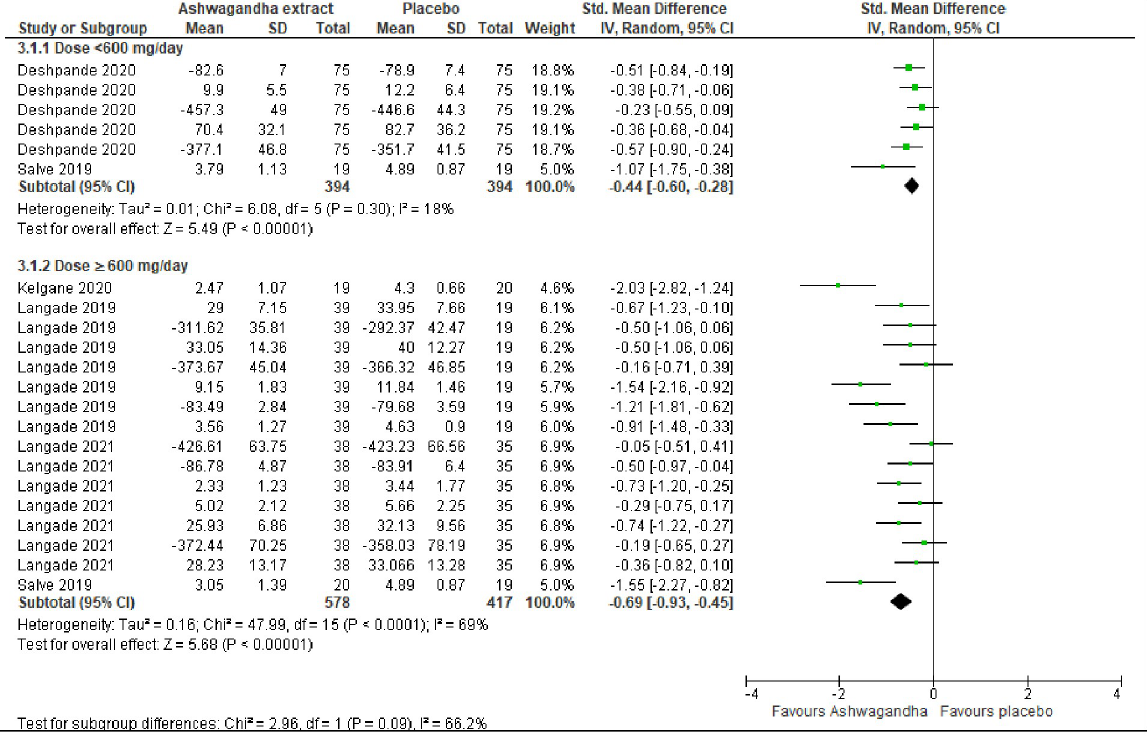
Fig 5. Forest plots of Ashwagandha versus placebo on sleep by treatment dosage.